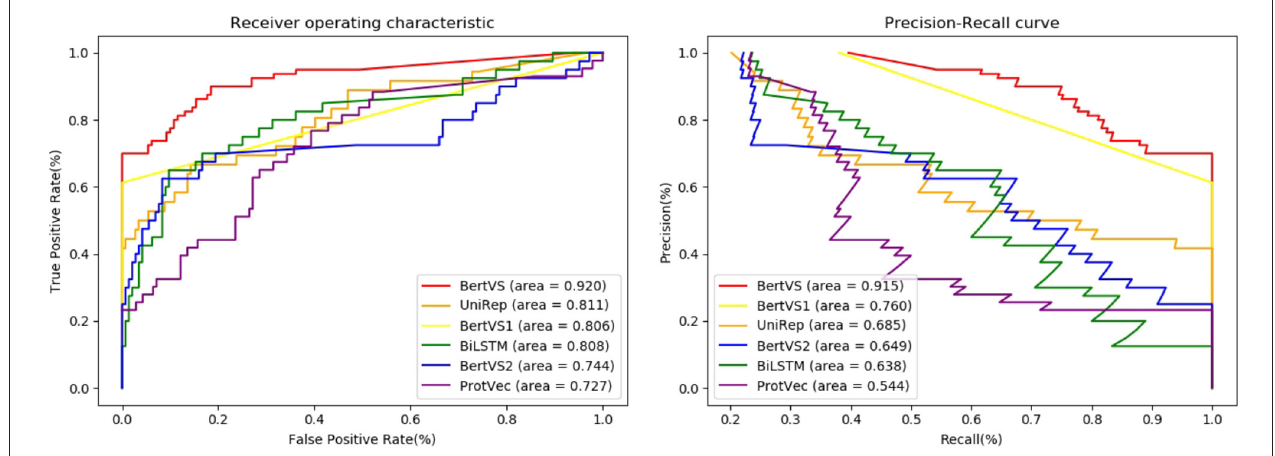
FIGURE 2 | Predictive performance of different methods on the BRCT dataset. Left: Receiver operating characteristic (ROC) curves of prediction results obtained by applying BertVS and other comparison methods. Right: Precision-recall (PR) curves for BertVS and other methods. Note that BertVS1 means our model in feature-based mode, while BertVS2 means our model without pre-training model.